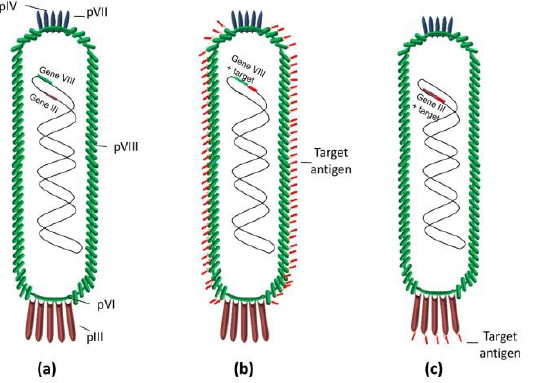
Figure 1. Scheme of bacteriophage M13: ( a ) wild-type phage; ( b ) phage displaying multivalent copies of the target antigen on pVIII protein; and ( c ) phage displaying multivalent copies of the target antigen on phage pIII protein. In both cases, the DNA fragments encoding the target antigens were cloned into a phage vector.